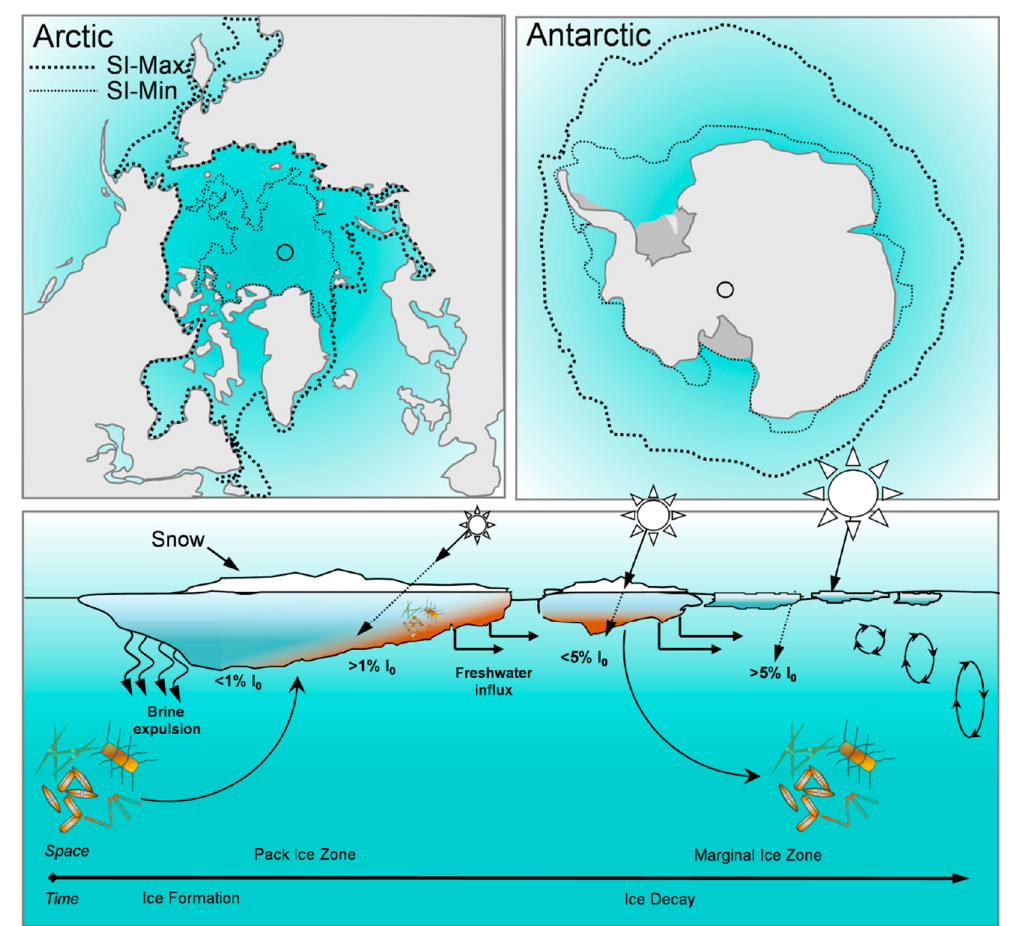
Figure 1. Sea ice zones in both polar regions. Stippled lines indicate the maximum (SI-Max) and minimum (SI-Min) extent of sea ice in the Arctic ( top left ) and Southern Ocean ( top right ). Black open circles indicate the poles. Schematic of the spatial and temporal evolution and decay of sea ice in polar marine ecosystems. Arrows indicate seasonal changes in salinity from brine extrusion and freshwater melt, as well as light attenuation, solar angle, and mixing depth. The entrainment of microalgae into the sea ice as it forms, its proliferation and re-release into the water column during melt is also shown. I 0 = percent incident irradiance.